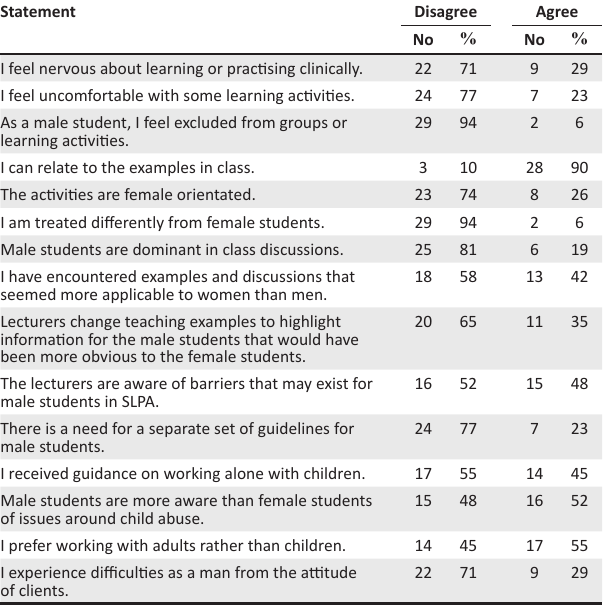
TABLE 4: Perceptions regarding the experiences during undergraduate training ( n = 31).